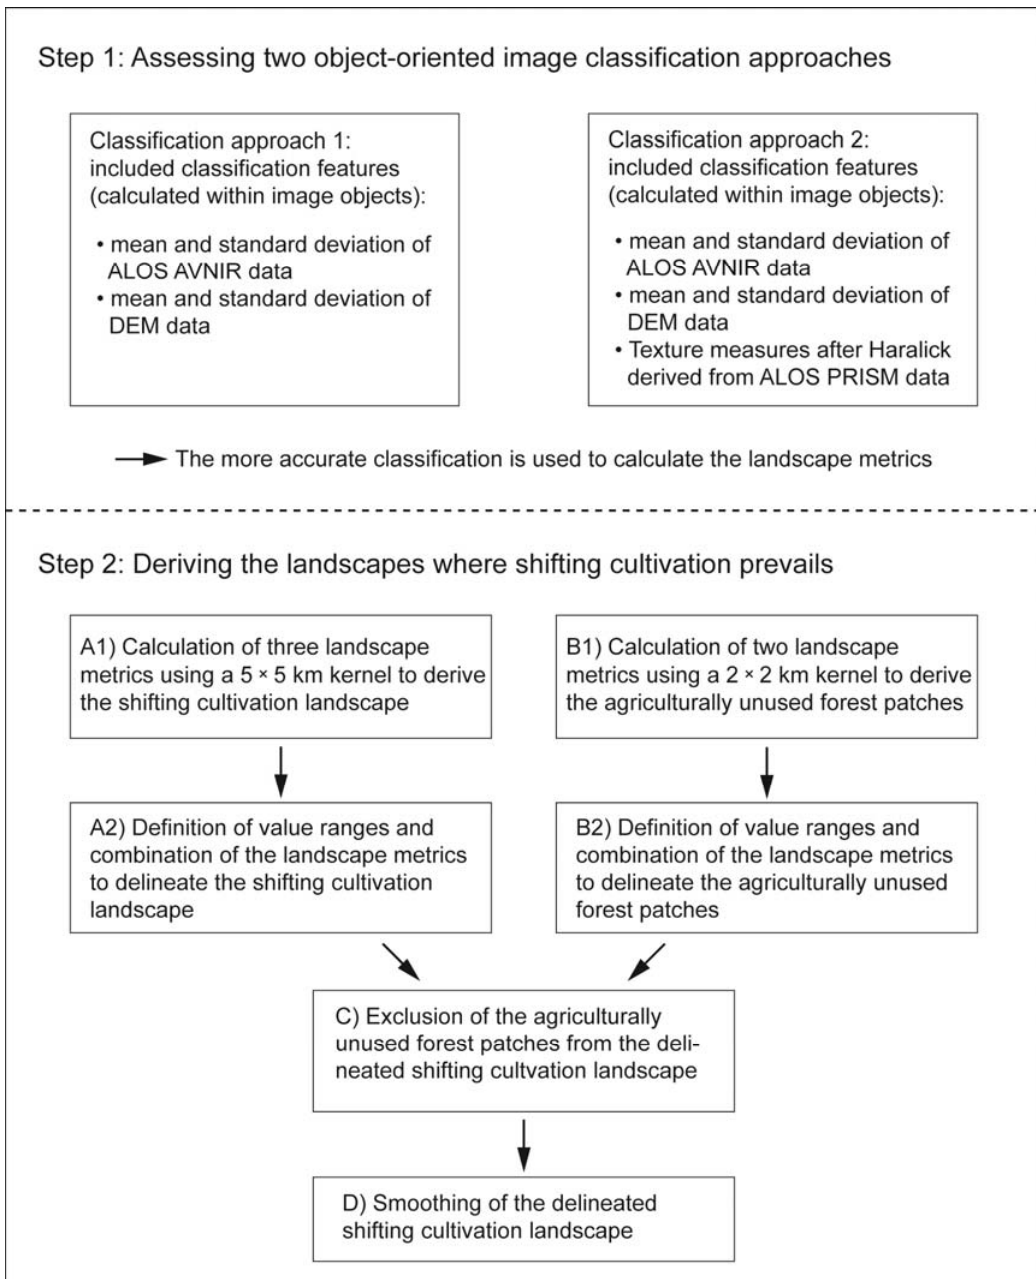
Figure 3. Approach to delineating shifting cultivation landscapes. ALOS, Advanced Land Observing Satellite; AVNIR, Advanced Visible and Near-Infrared Spectrometer; PRISM, Panchromatic Remote-sensing Instrument for Stereo Mapping; DEM, Digital Elevation